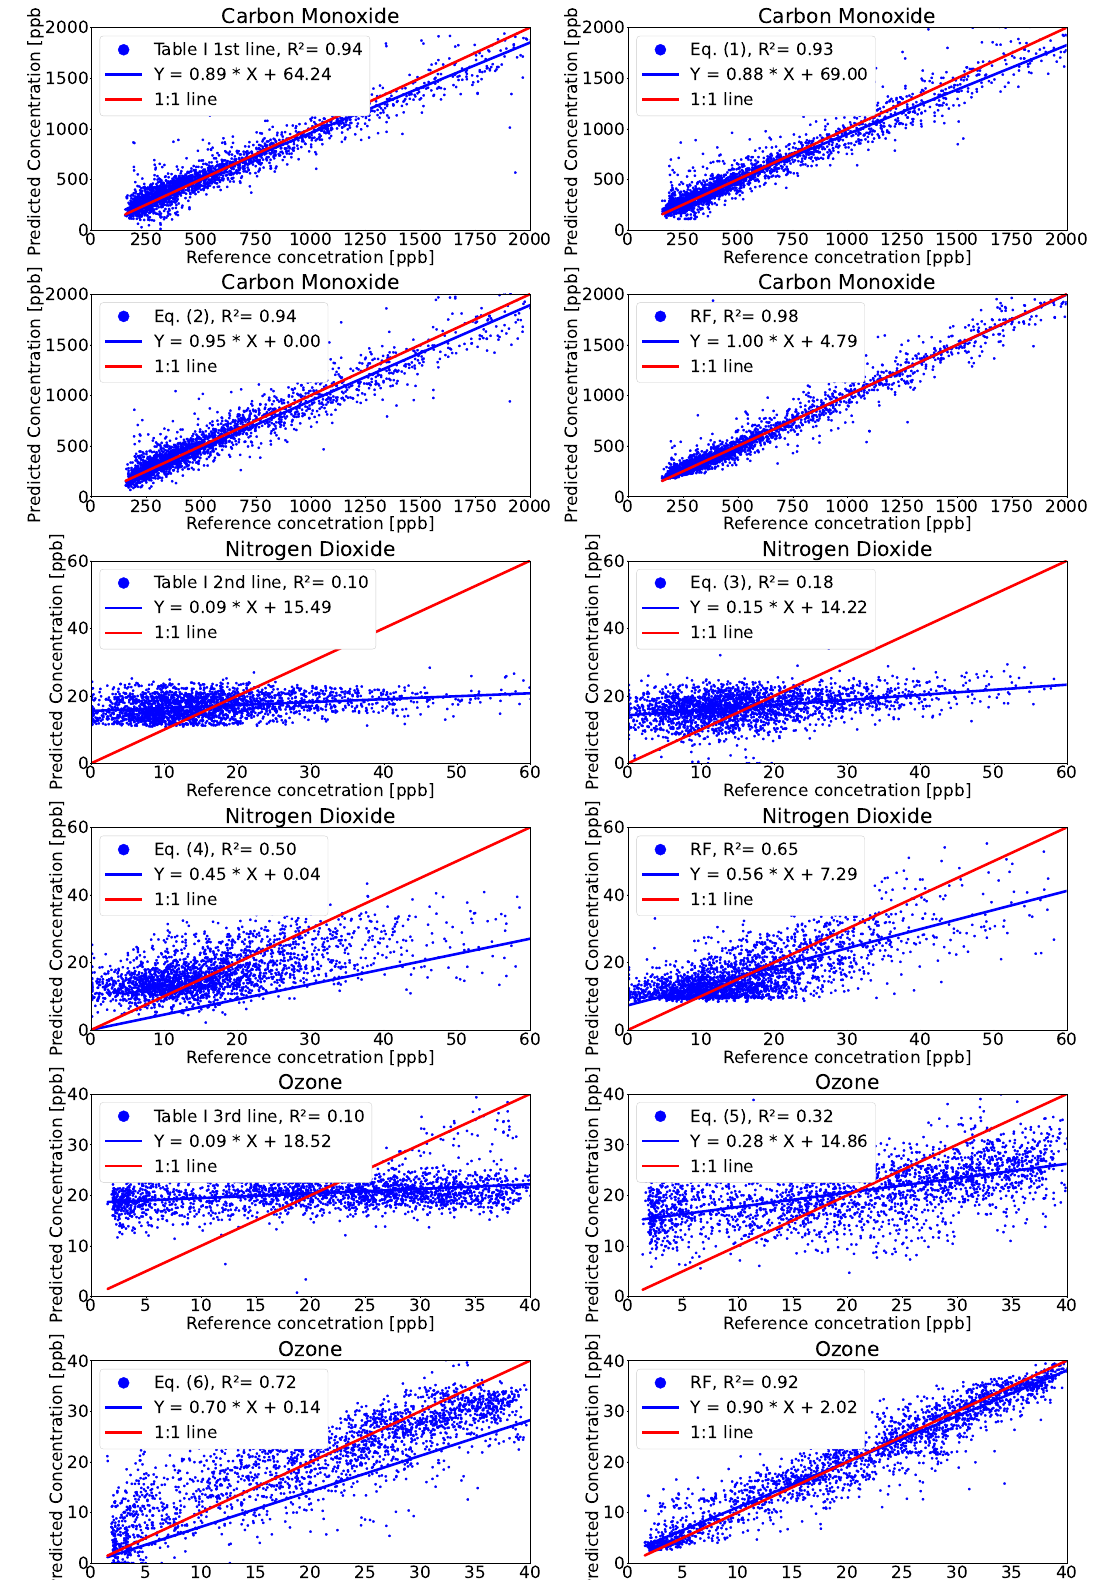
Figure 3. Scatterplot of calibration sensor data using the proposed models against reference